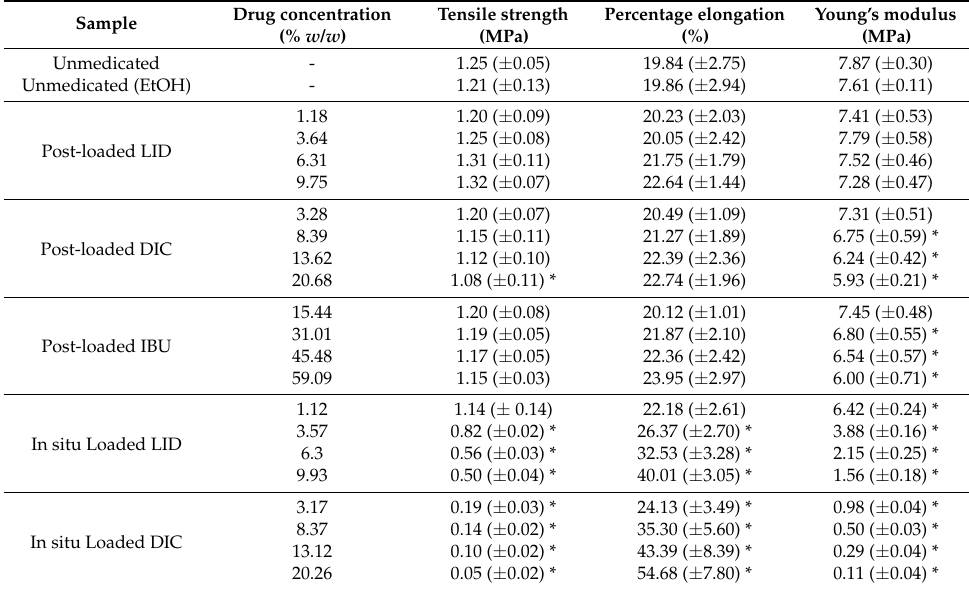
Table 5. Effect of loading method and drug physicochemical properties on the mechanical properties. Values in brackets indicate the standard deviation from reported mean ( n = 3; * Significantly different from corresponding unmedicated hydrogels; p <